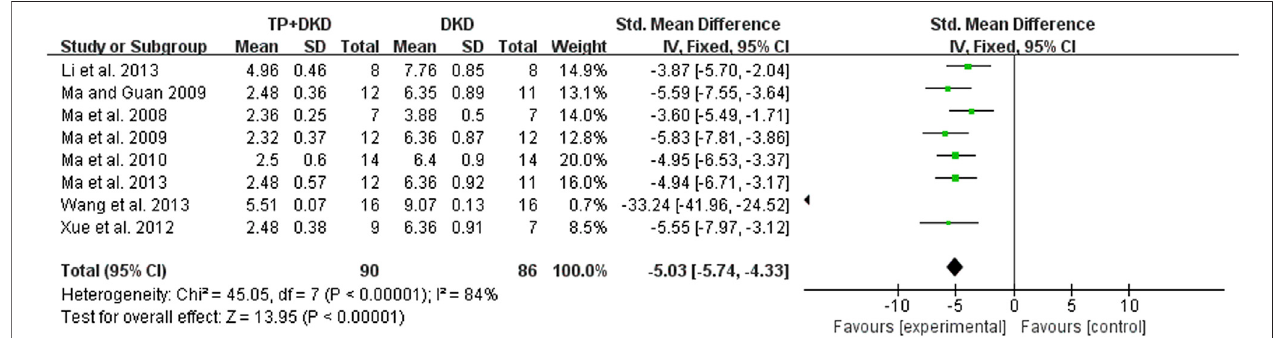
FIGURE 4 | Forest plot of UACR outcome.